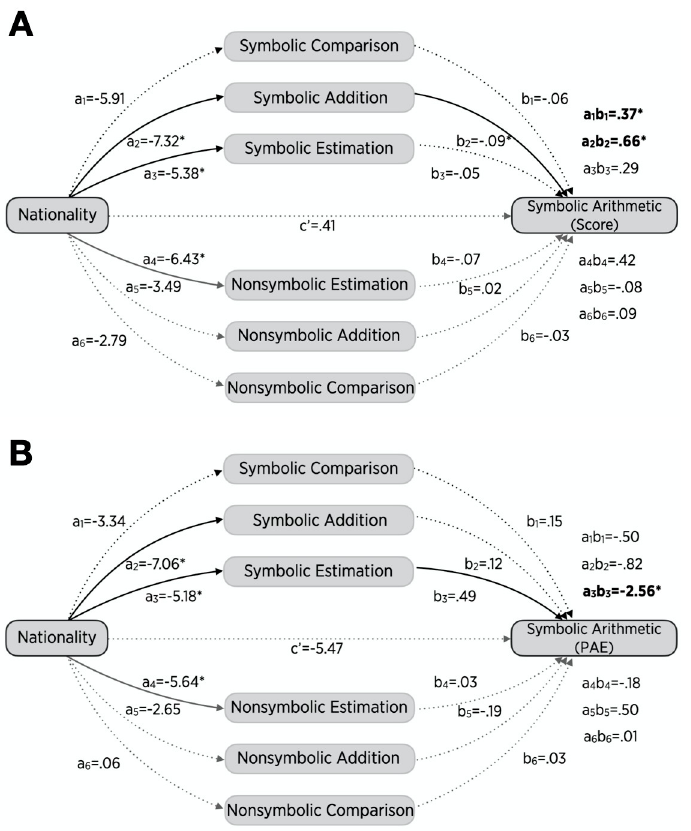
Fig 5. Multiple mediation analyses with arithmetic scores (A) and arithmetic PAEs (B) as an outcome variable. Solid and dotted lines represent significant and non-significant relations between variables, respectively. Results imply that a substantial amount of the nationality effects may occur through the numerical magnitude tasks